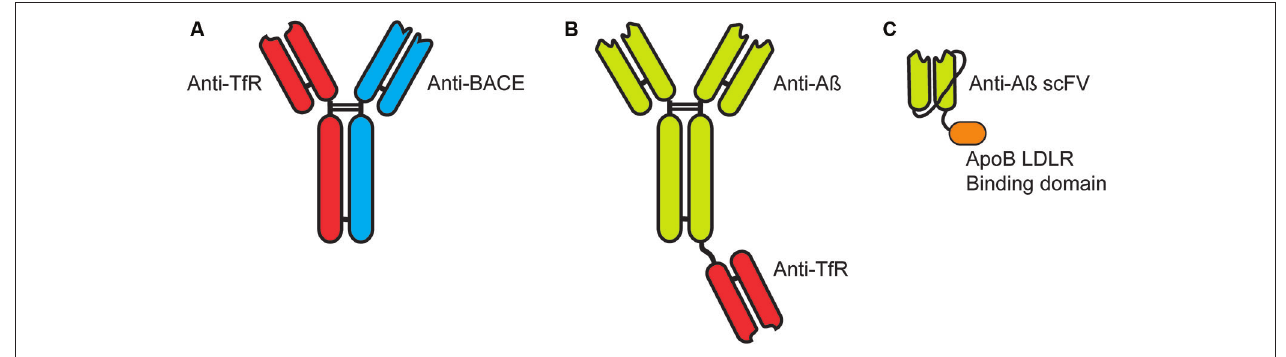
by the knobs into holes approach. (C) Single chain antibody (scFV) targeted to A β expressed with a linker between the heavy and light chain with a linker to the LDLR binding domain of Apolipoprotein B (38 amino